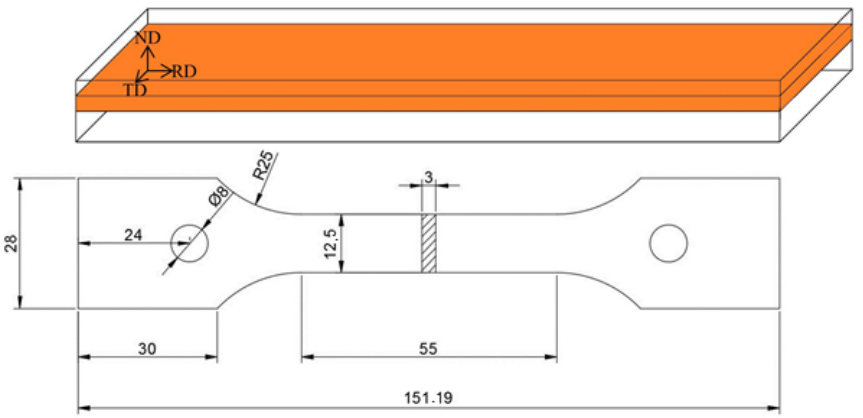
Figure 2. Schematic illustration of the tensile specimen sampling position and the dimensions of the tensile test specimen (mm).